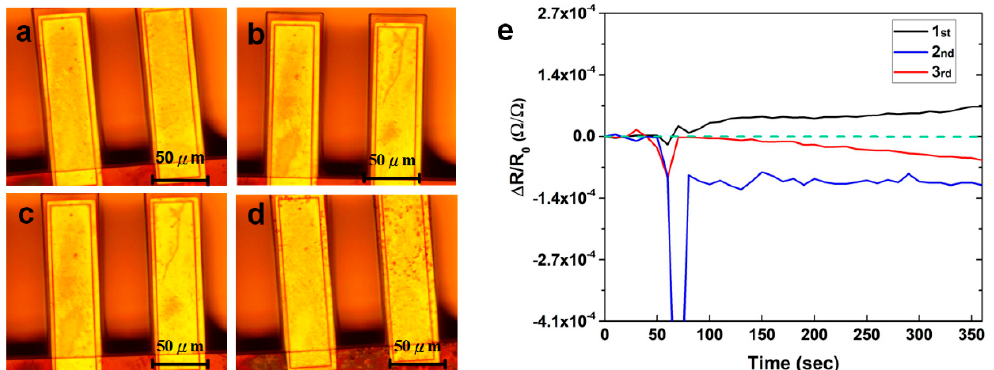
Figure 5. The optical microscopic images of PEDOT:PSS films coated on microcantilevers: ( a ) before exposure to 10 ppm of Pb 2 + solution; ( b ) after exposure to 10 ppm of Pb 2 + solution for the first measurement; ( c ) after the second measurement; ( d ) after the third measurement; and ( e ) each signal response of the sensor for the three separate measurements in a 10 ppm of pb 2 + solution.